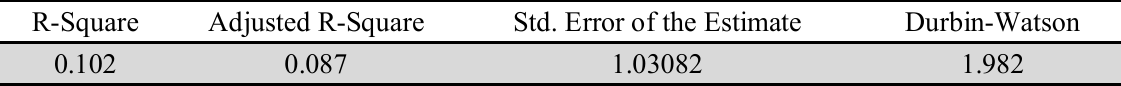
The Summary Normalization of remaining distribution R-Square